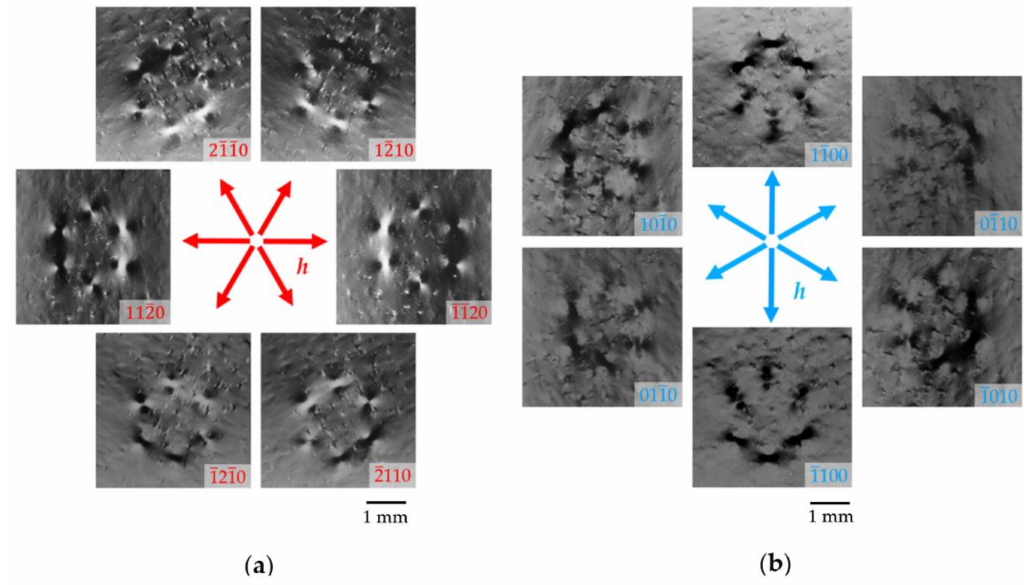
Figure A1. Transmission SWB-XRT of the HCD-A (Figure 2b): ( a ) 1120 reflections family, ( b ) 1100 reflection family. For the 1120 reflection family, the position of the light and dark contrast lobes changes depending on the direction of the diffraction vector. For the 1100 reflection family, only dark contrasts are observed; these show differences in their broadening depending on the orientation to the diffraction